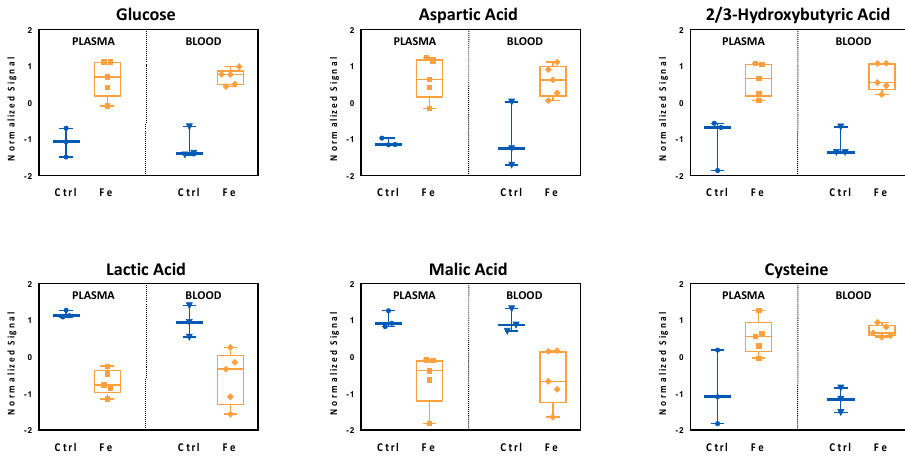
Figure 3. Plasma and blood metabolite profiles were compared and highlight alterations of glucose homeostasis as well as oxidative stress induction by iron challenge. Comparison of normalized signals of selected metabolites extracted from plasma and blood show that the profiles are very similar. Controls (Ctrl, blue, n = 3), high-iron diet (Fe, orange, n = 5). Statistics: Student t -test was performed, a p -value < 0.05 was considered to be